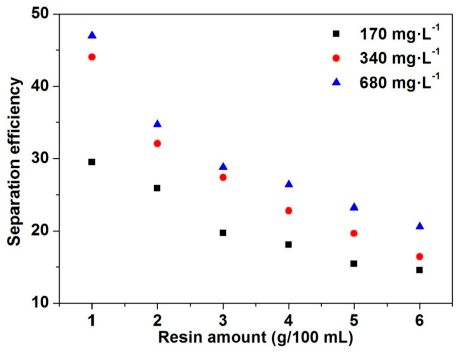
Figure 2. Separation efficiency (iron-to-copper ratio) by Rexp-501 at various concentrations, 298 K. Copper and iron in the same concentrations.